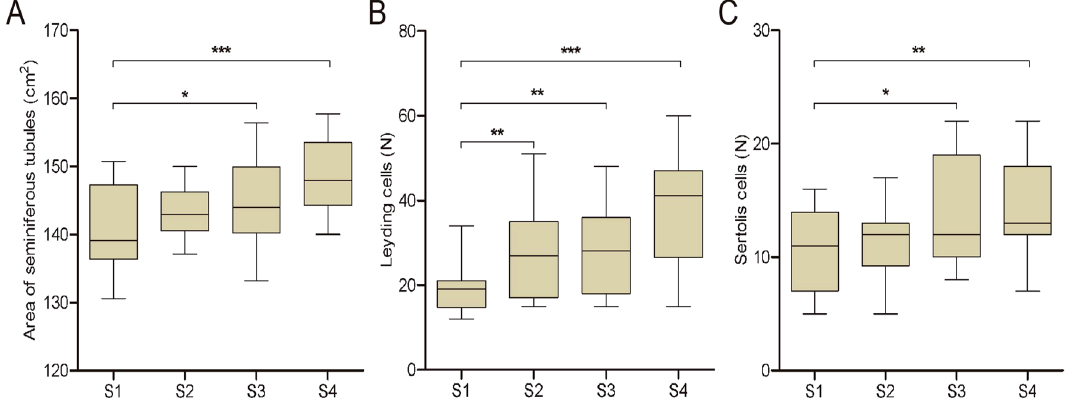
Figure 3. Morphological differences in testes of piglets at 82 days of age. ( A ) Area of seminiferous tubules. ( B ) Number of Leydig cells. C. Number of Sertoli cells. The values shown are the means ± SEM (Significant difference: * P < 0.05; ** P < 0.01; *** P < 0.001). S1: control diet; S2: control diet supplemented with 1 μg/kg 1α,25(OH) 2 VD 3 ; S3: control diet supplemented with 2 μg/kg 1α,25(OH) 2 VD 3 ; S4: control diet supplemented with 4 μg/kg 1α,25(OH)